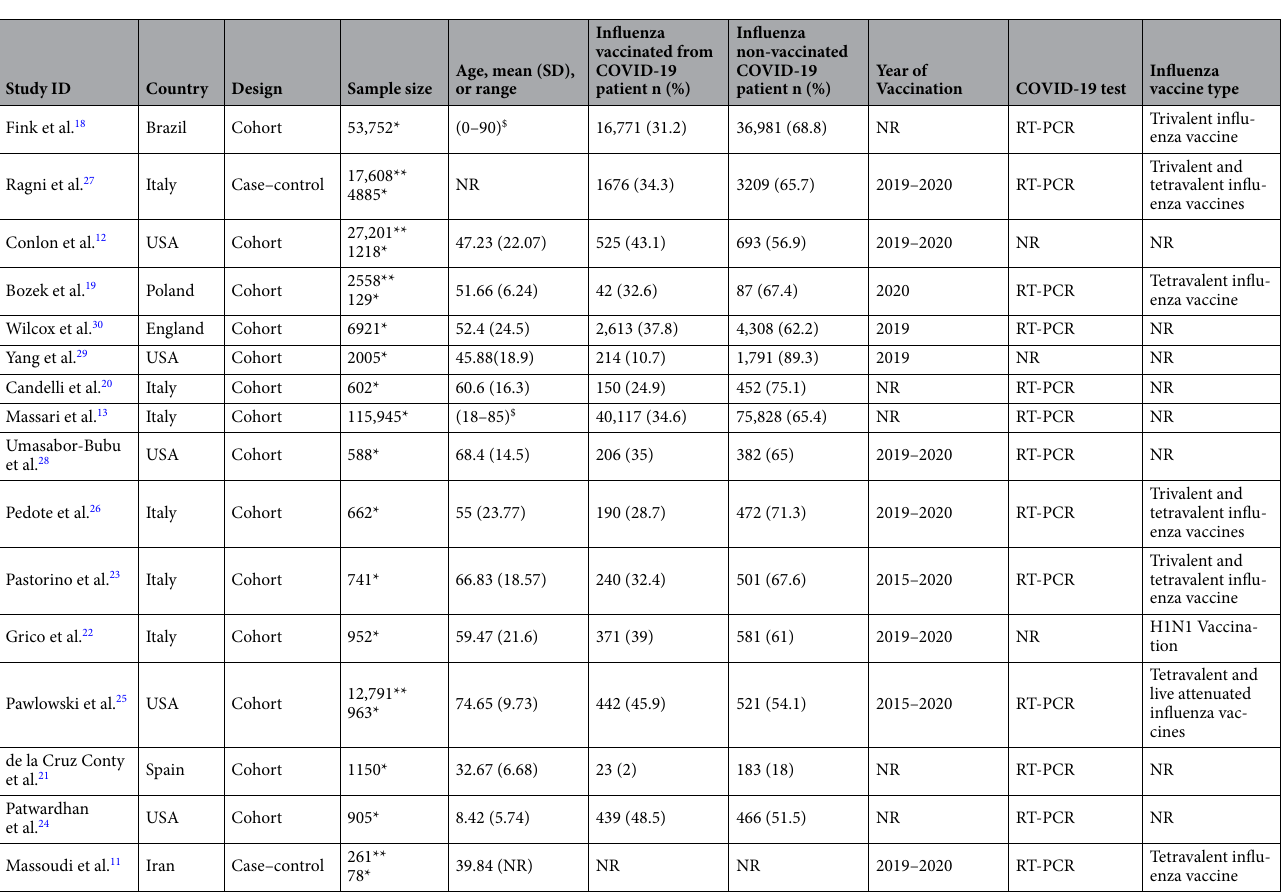
Table 1. Summary of the included studies. SD, Standard deviation; RT-PCR, Reverse transcription polymerase chain reaction; (**), Total population contain positive and negative COVID-19; (*), COVID-19 positive patients; ( $ ), Age in range; NR, Not